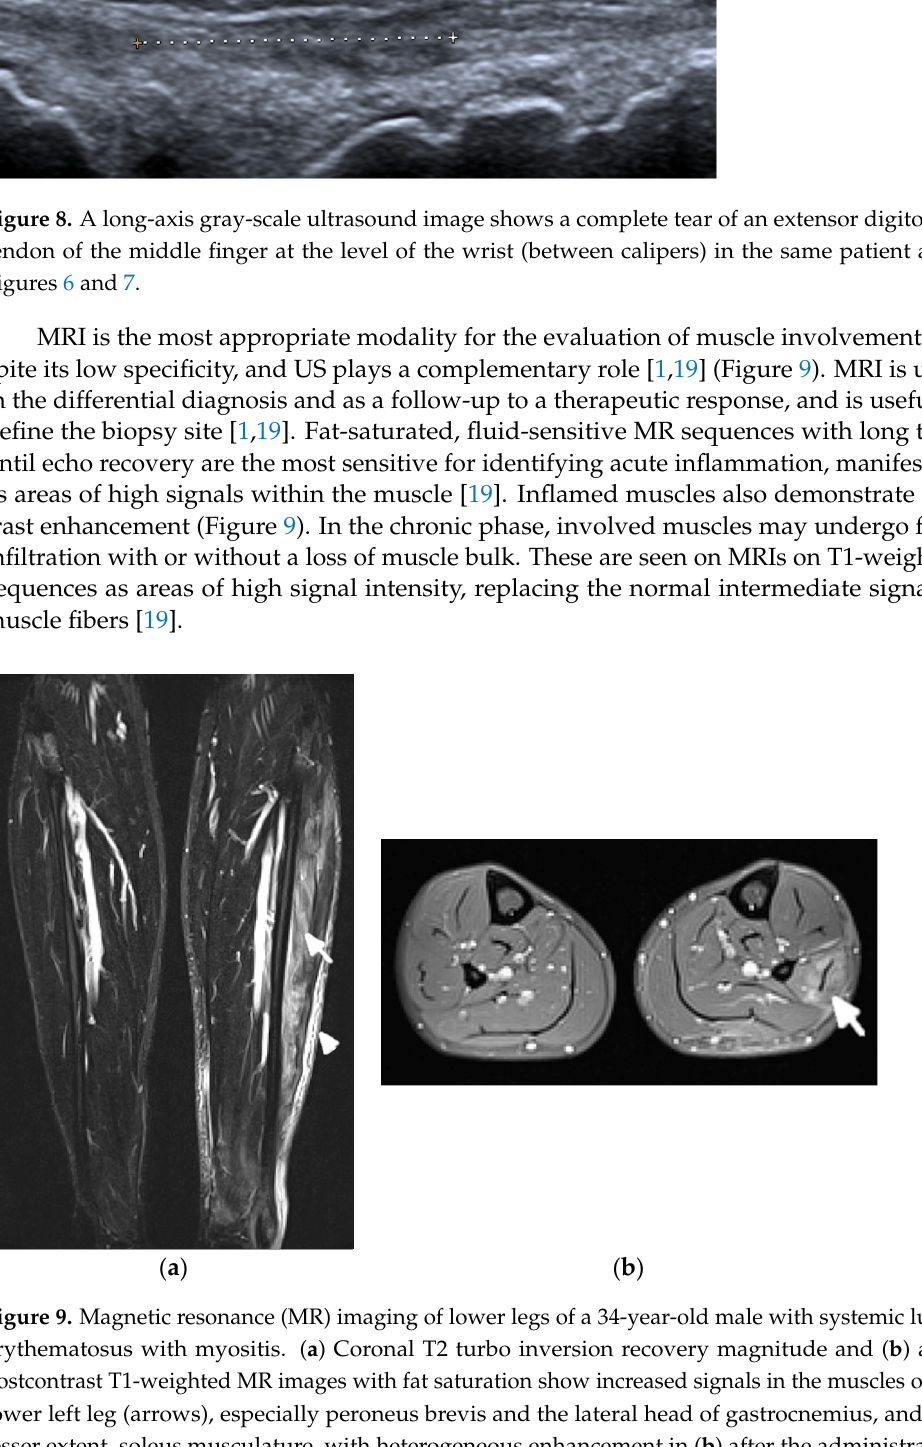
Figure 7. A complete tear of the proximal part of the bare tendon of the distal biceps brachii bilaterally in the same patient as in Figure 6. Short-axis ( a , b ) and long-axis ( c , d ) gray-scale ultrasound images of the bilateral elbow/distal arms show rupturing of the bilateral distal biceps tendons at the level of the myotendinous junction with hypoechoic proximal stums consistent with tendinopathy (arrows). In ( c , d ), note the retracted bilateral biceps muscles.